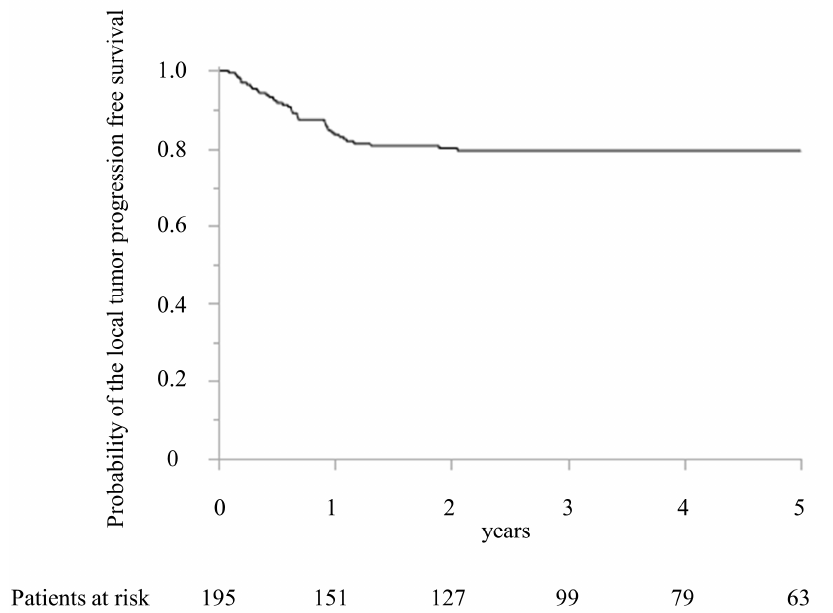
Figure 3. Kaplan–Meier curve of the local tumor progression-free survival after microwave ablation. The LTPFS were 83.7% and 80.2% at 1 and 2 years, respectively. The maximum period of local recurrence was 729 days after surgery. Compared with the patients’ characteristics between the local recurrence and no local recurrence groups, the timing of CRLM, the largest diameter of CRLM treated with MWA, the number of CRLM treated with MWA, and preoperative chemotherapy were significantly different (Table 1). Table 1. Comparison of baseline characteristics of CRLM in patients with and without local recur- rence following treatment with MWA.